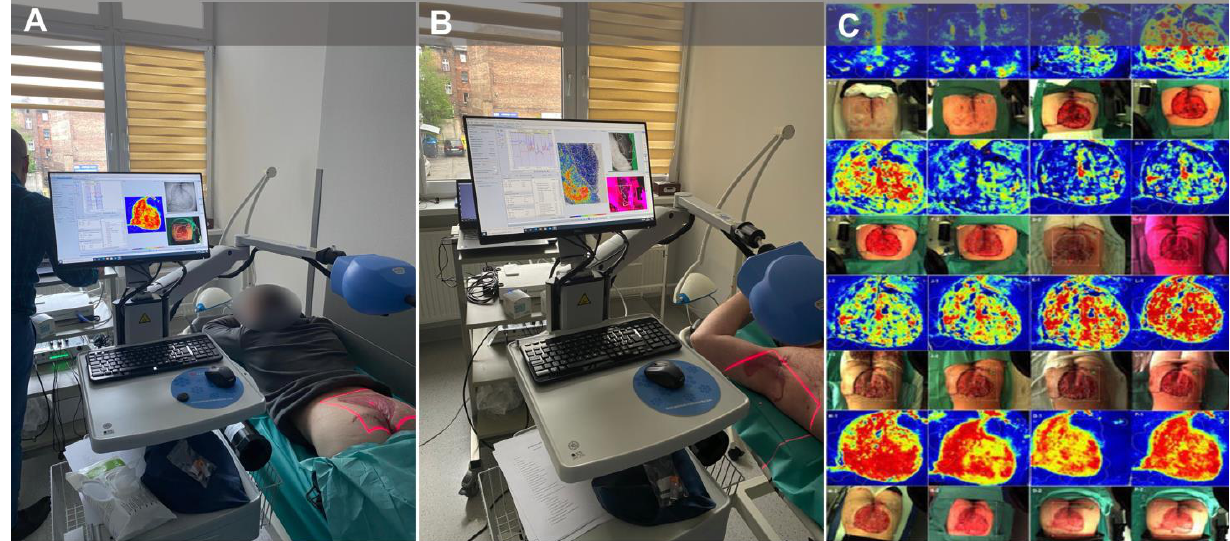
Figure 3. Laser speckle contrast analysis examinations. ( A ) patient during the LASCA examination after co-graft of ADM and STSG surgery (buttocks); ( B ) patient during the LASCA examination after co-graft of ADM and STSG surgery (right axilla); ( C ) microcirculatory perfusion and the healing process over a period of time (patient with co-graft of ADM and STSG to the buttocks). Legend: LASCA, laser speckle contrast analysis; ADM, acellular dermal matrix; STSG, split-thickness skin